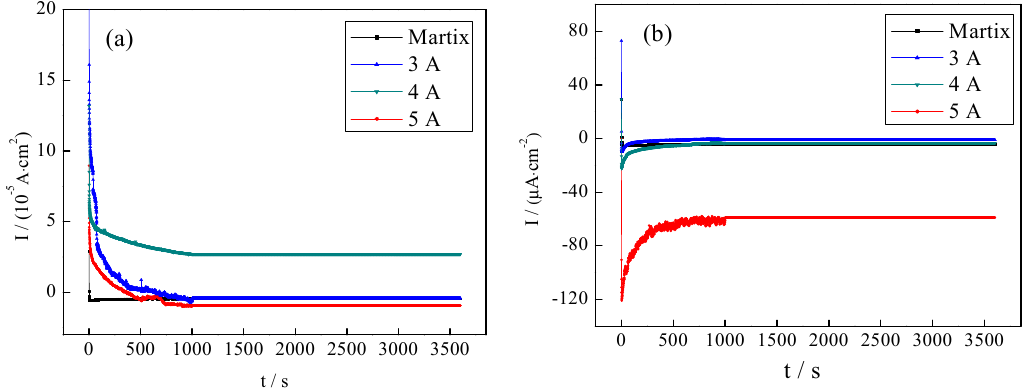
Figure 8. Potentiostatic polarization curves of the CrN x coating in the working environment of the PEMFC bipolar plate (( a ) cathodic working environment, ( b ) anodic working environment). PEMFC bipolar plate (( a ) cathodic working environment, ( b ) anodic working